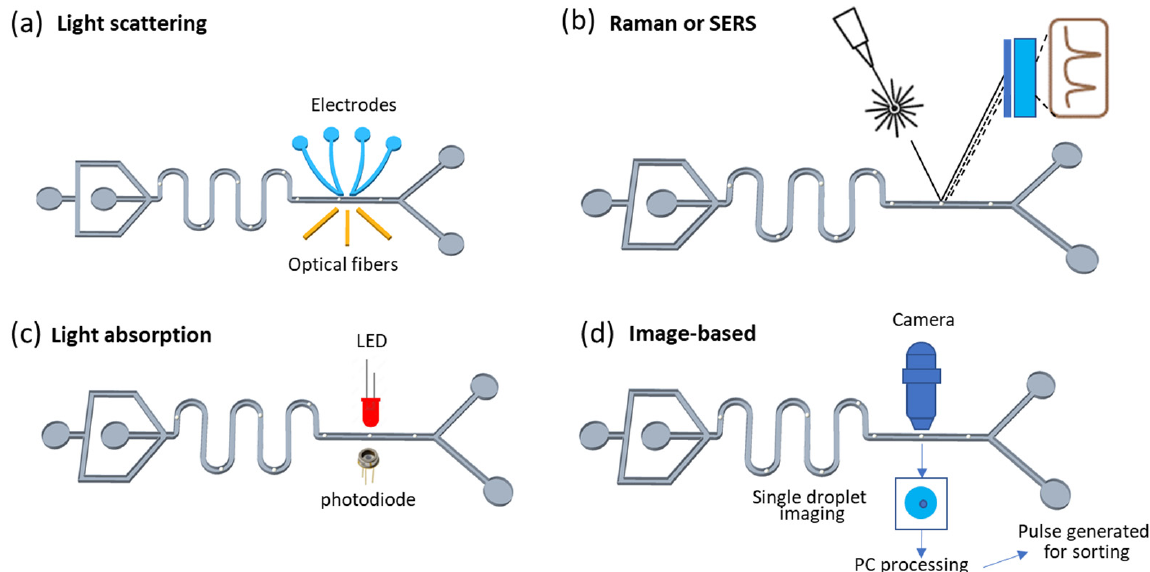
Figure 3. Schematic illustration of droplet detection approaches based on visible light. ( a ) Light scattering-based method integrated with multiple optical fibers; ( b ) Raman or surface-enhanced Raman scattering method for droplet detection; ( c ) light absorption-based method integrated with LED-photodiode pair; ( d ) image-based droplet detection coupled with rapid high-resolution camera.